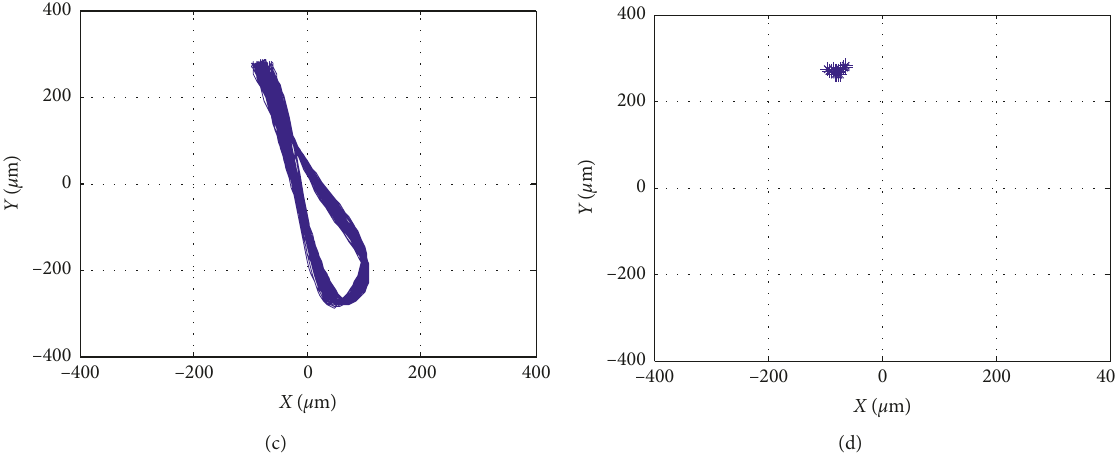
Figure 11: Local slight rubbing at 3000r/min. (a) Time-domain waveform. (b) Spectrum graph. (c) Axis orbit. (d) Poincare orbit.